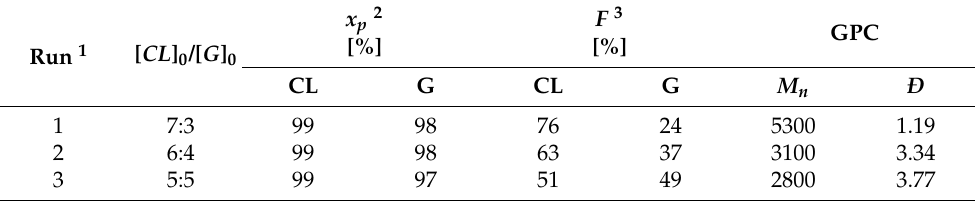
Table 5. Results for copolymerization of CL with glycidol (G) using DMC catalyst